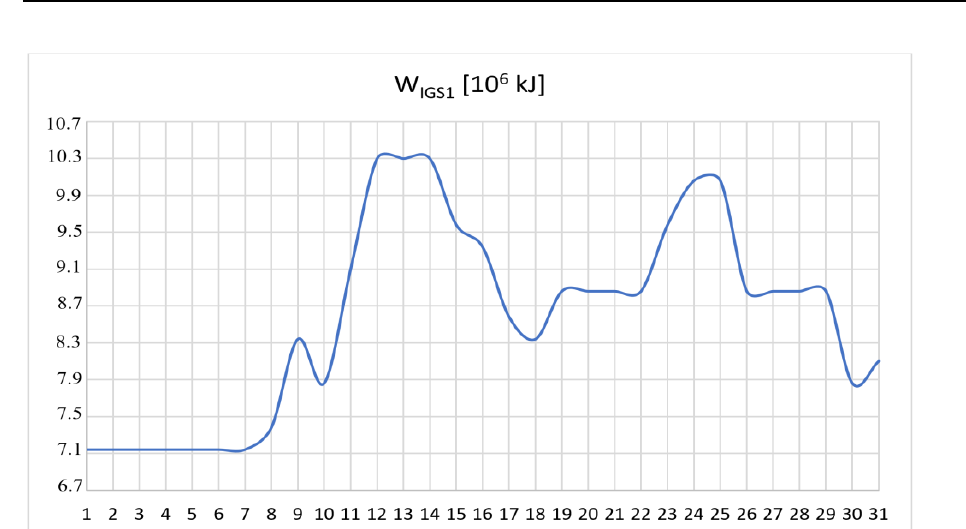
Figure 6. TE daily consumption for TS1 [January 2019].